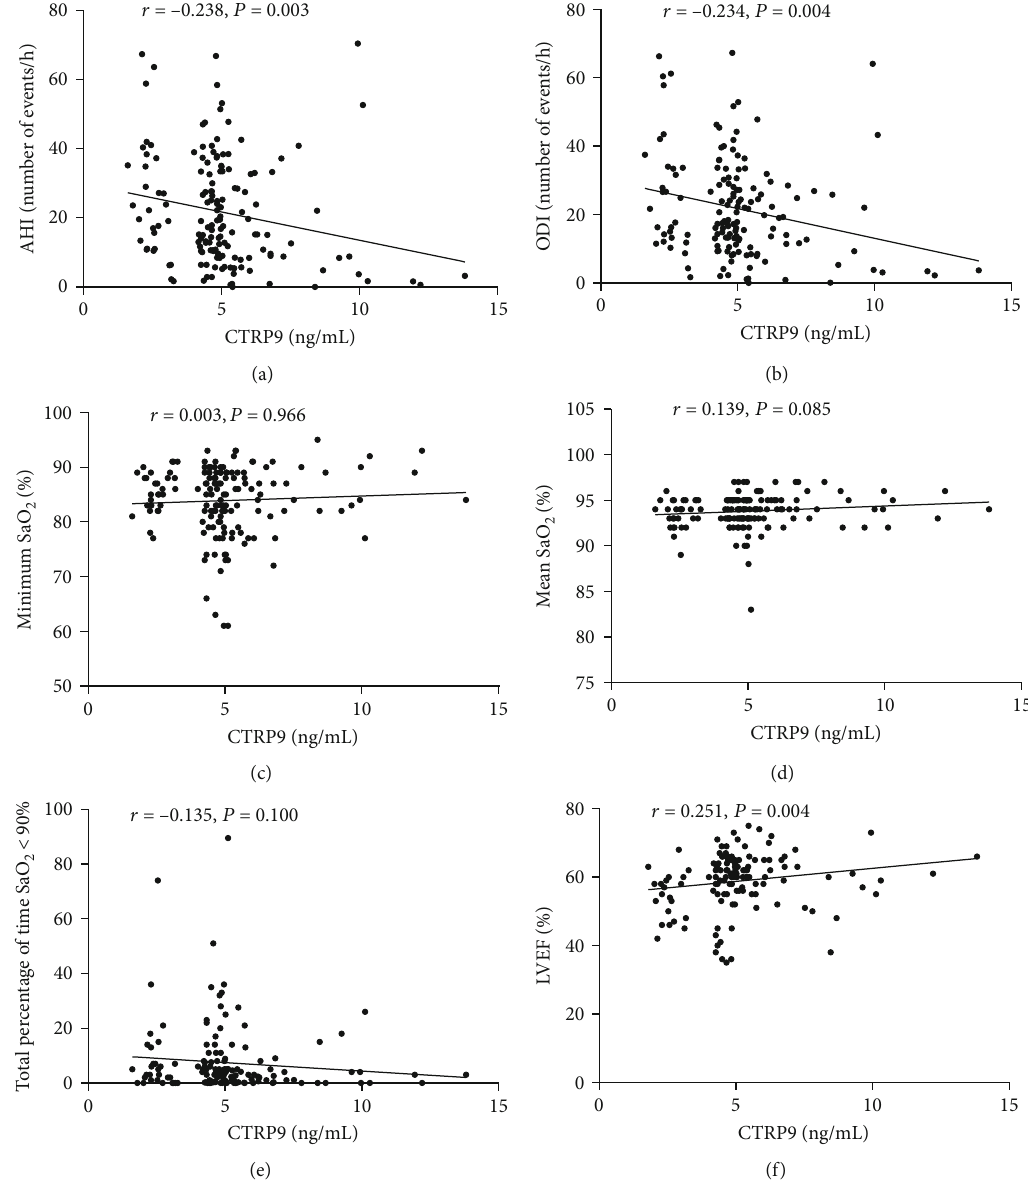
Figure 3: Correlation between CTRP9 and parameters of sleep study (a – e) and LVEF (%) (f). AHI: apnea-hypopnea index; LVEF: left ventricular ejection fraction; ODI: oxygen desaturation index; SaO